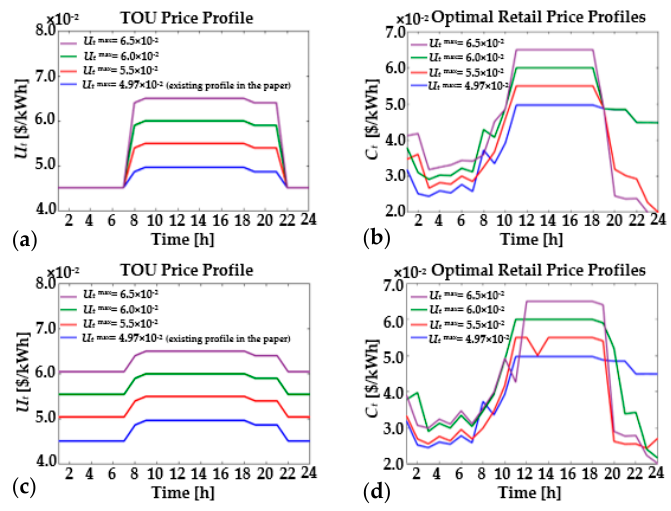
Figure 10. Effects of the various U t profiles: ( a ), ( c ) price caps U t and ( b ), ( d ) optimal profiles C t .